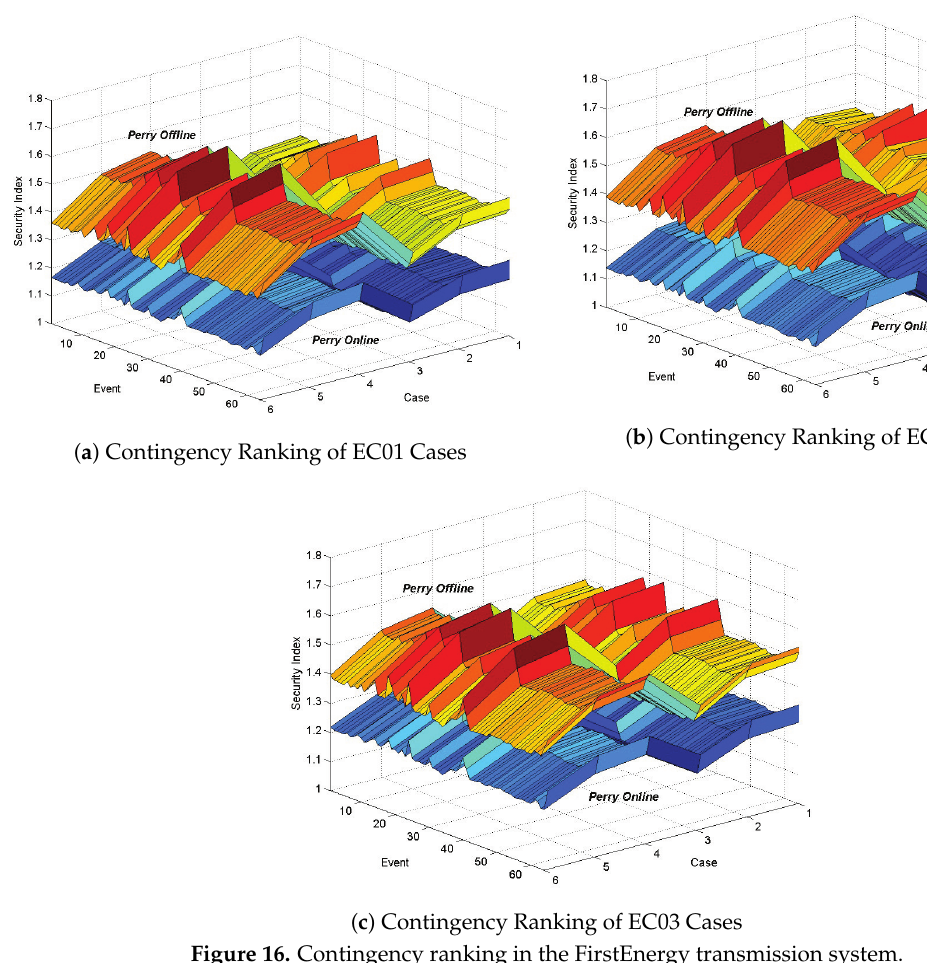
Figure 16. Contingency ranking in the FirstEnergy transmission